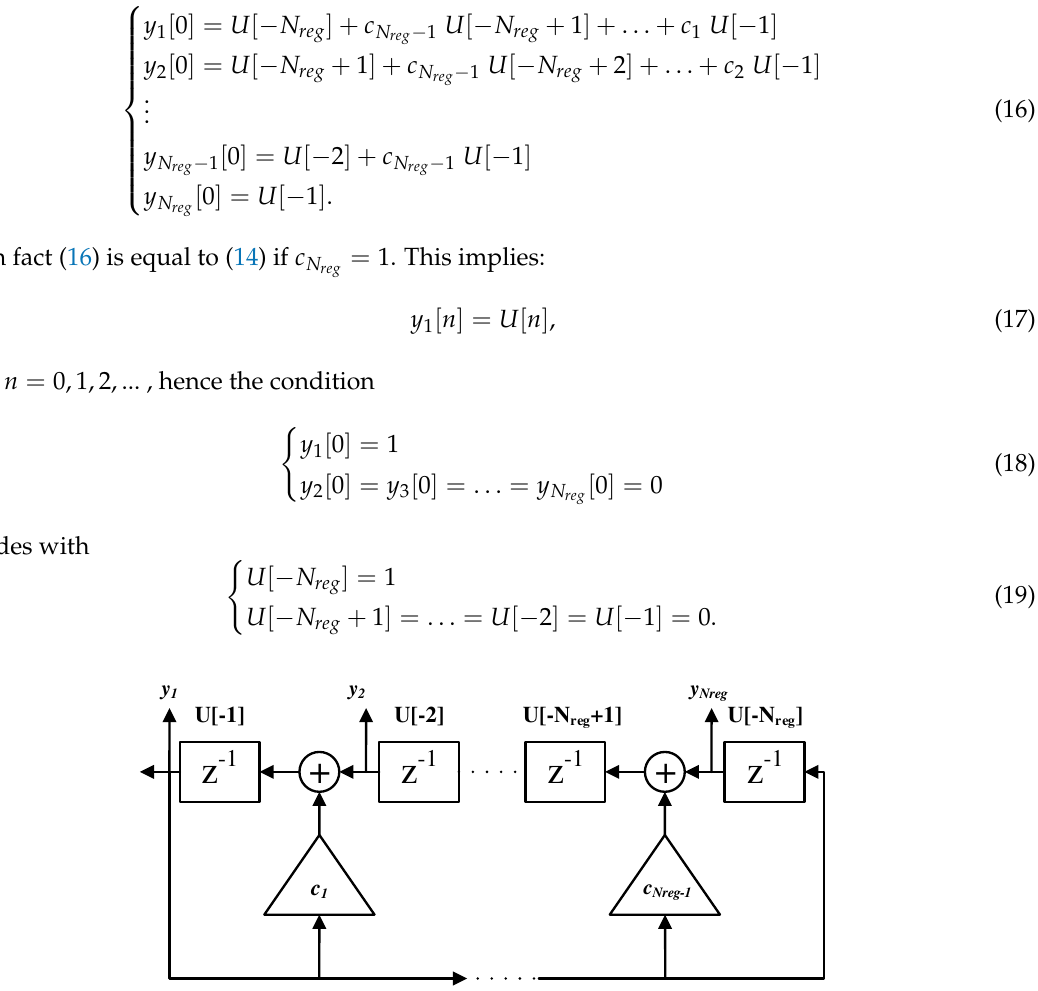
Figure 4. Digital schematic used for the generation of the binary weights y 1 , . . . , y N